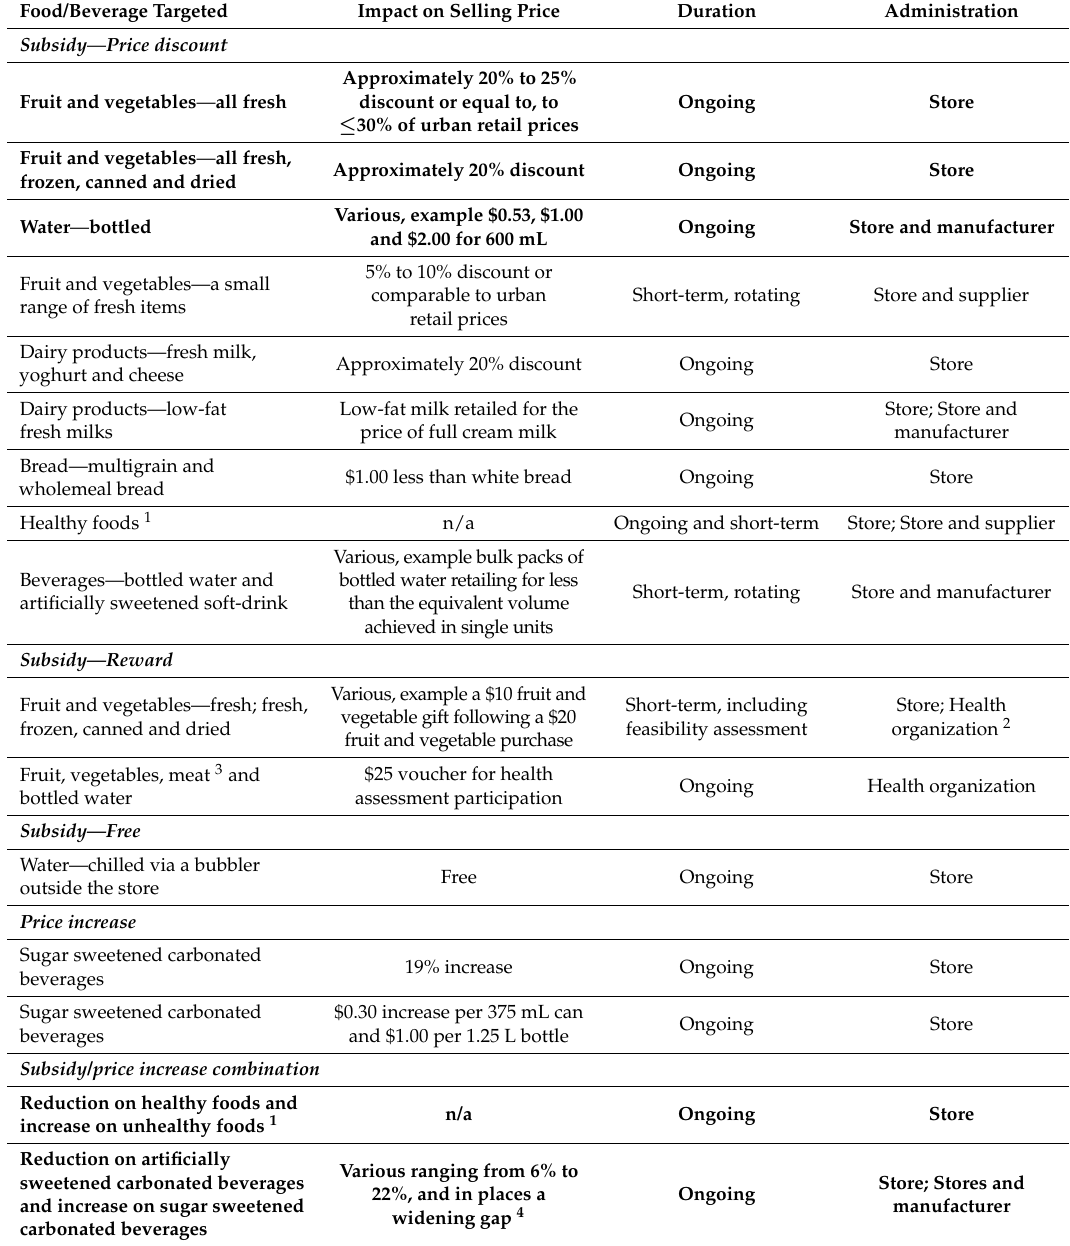
Table 1. Health-promoting food pricing policies in very remote Aboriginal and Torres Strait Islander community stores in